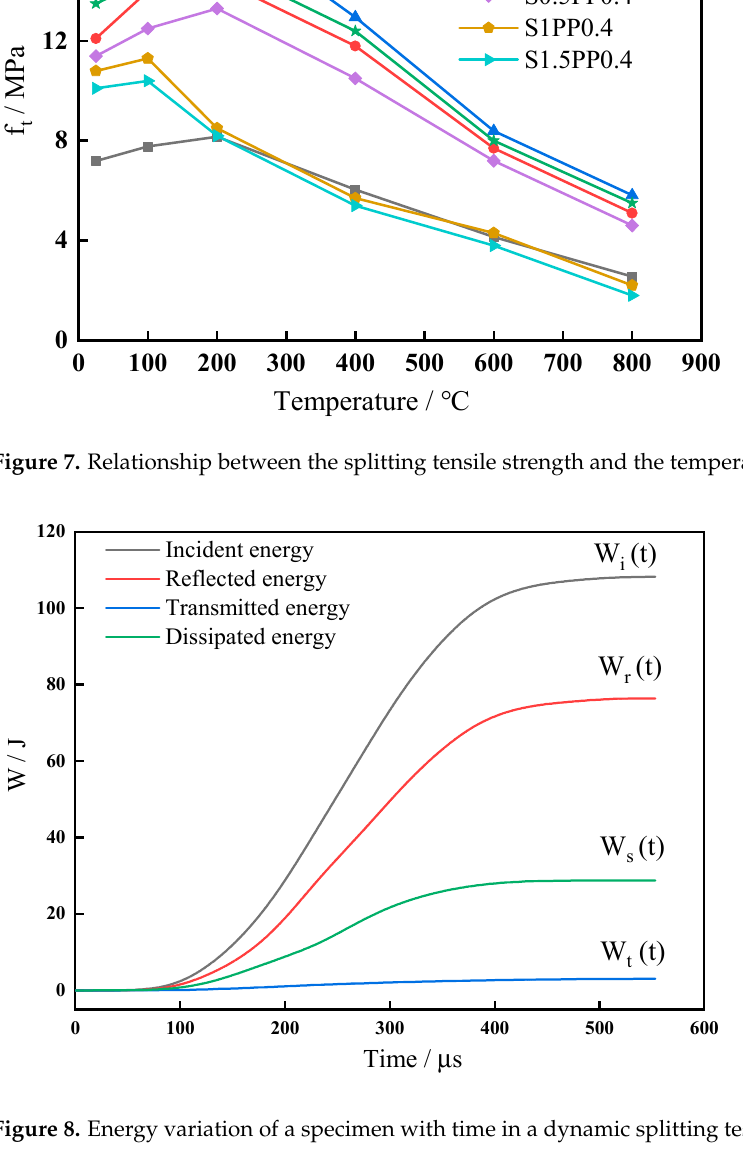
( b ) Figure 9. Time history curve of dynamic splitting dissipation energy of concrete under different temperature groups:( a ) PC; ( b ) S1PP0.2. Introducing damage variables into concrete materials can better study the defor- mation and failure characteristics of materials. In the constitutive relationship, the accom- panying variable of damage variable, namely the damage propagation force, refers to the energy dissipation density, so it is more meaningful to define the damage variable from the perspective of energy dissipation. According to the energy point of view, concrete material deforms after being subjected to impact load, and the bearing capacity of the material gradually decreases in this process. That is, the constitutive energy of the material also decreases. It is more reasonable to define damage in combination with the relation- ship between material performance degradation and energy dissipation. Based on the pre- vious research results [26], E ς is defined as the constitutive energy of the material, E λ as the deformation energy, and D ο as the damage variable.